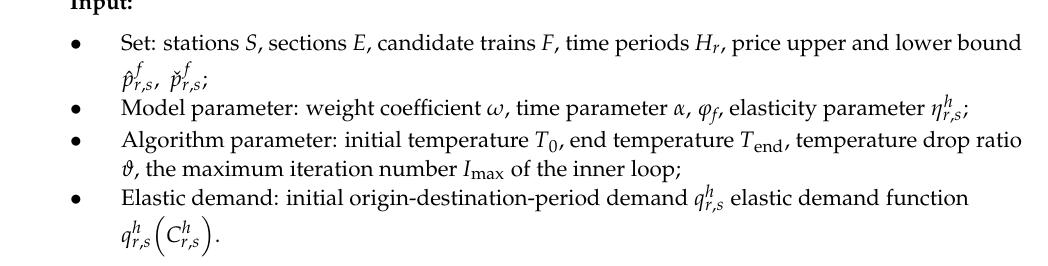
Algorithm 1 Simulated Annealing